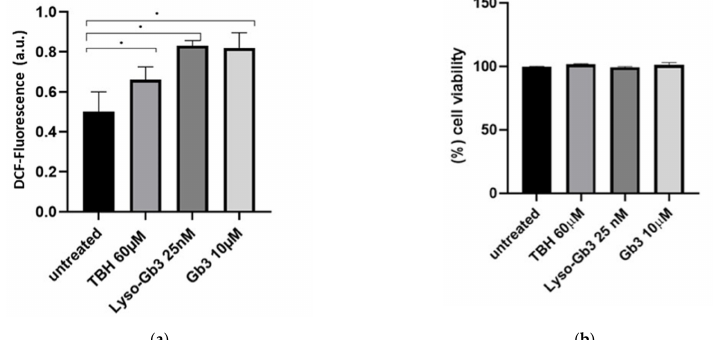
Figure 7. Lyso-Gb3 and Gb3 effect on HUVECs. Intracellular ROS levels and cell viability were assayed in HUVECs treated with TBH 60 µM, Lyso-Gb3 25 nM, and Gb3 10 µM. Intracellular ROS were measured as fluorescence intensity, using a DCFH-DA probe. The results, in arbitrary units (au), are presented as mean ± SD of three different experiments analyzed in triplicate ( a ). Cell viability was evaluated with MTS assay. The results presented as mean % of viable cells ± SD of three different experiments analyzed in triplicate ( b ). Comparison among multiple groups was analyzed by one-way analysis of variance, followed by Bonferroni’s post hoc test. * p < 0.01.